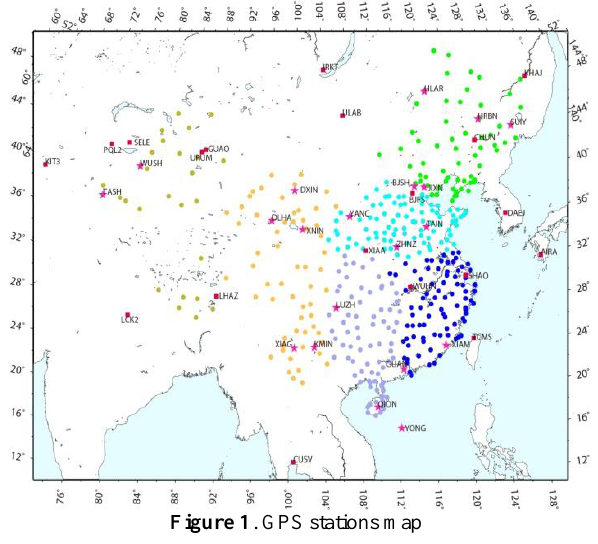
Figure 2 . Comparative analysis fitting results of polynomial and spline function. The black dot in the figure represents the residual time series, the blue curve is the polynomial